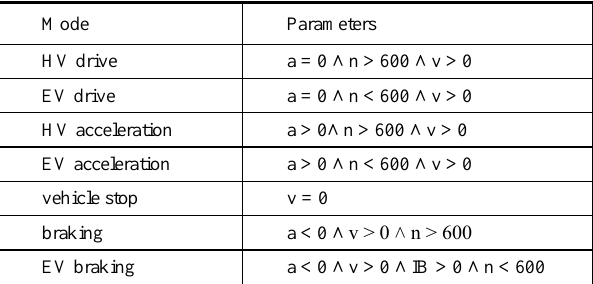
Table 3. Criteria for determining individual modes during the test